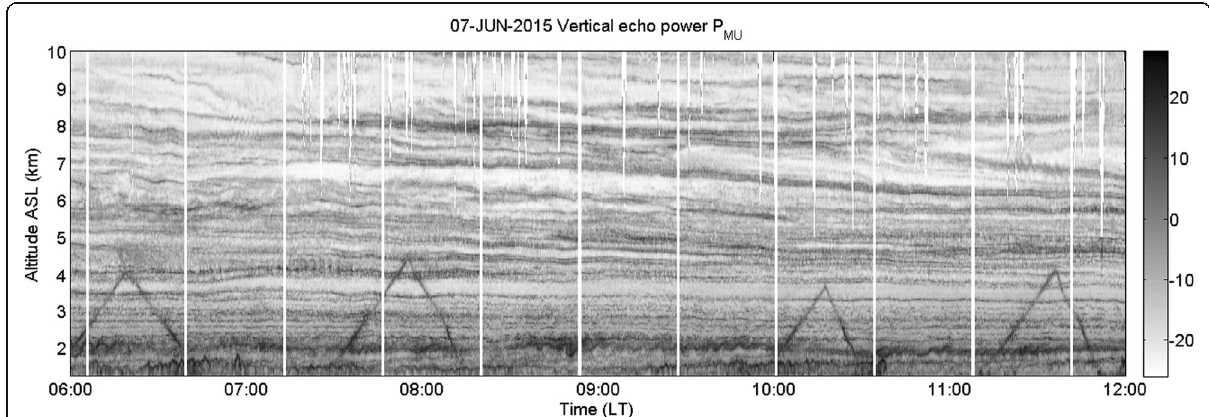
Fig. 10 Same as Fig. 5a, but from 06:00 to 12:00 LT on June 7 in the height range 1.27 – 10.0 km. Traces of flights UAV 4, 5, 6, and 7 can be seen from left to right . The lower part of the atmospheric column consists of “ sheets and layers ” structures throughout this period. Occurrence of KH billows can be noted around 2.0 km (e.g., after 06:00 LT and before 10:00 LT), where echo power is enhanced